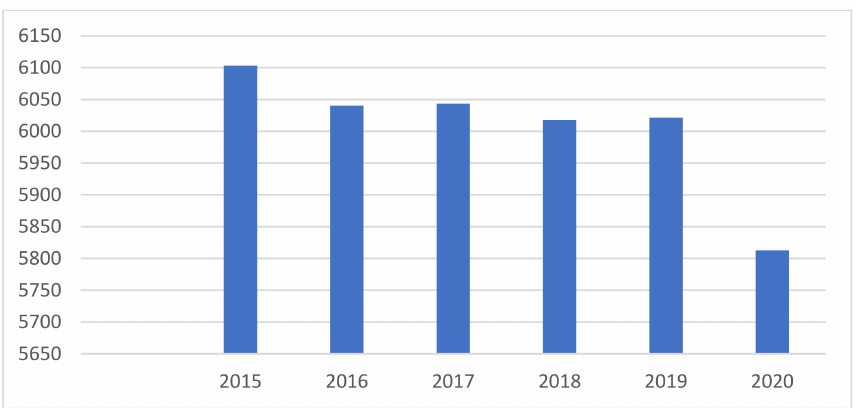
Figure 1. China’s water consumption in 2015–2020 (100 million cubic